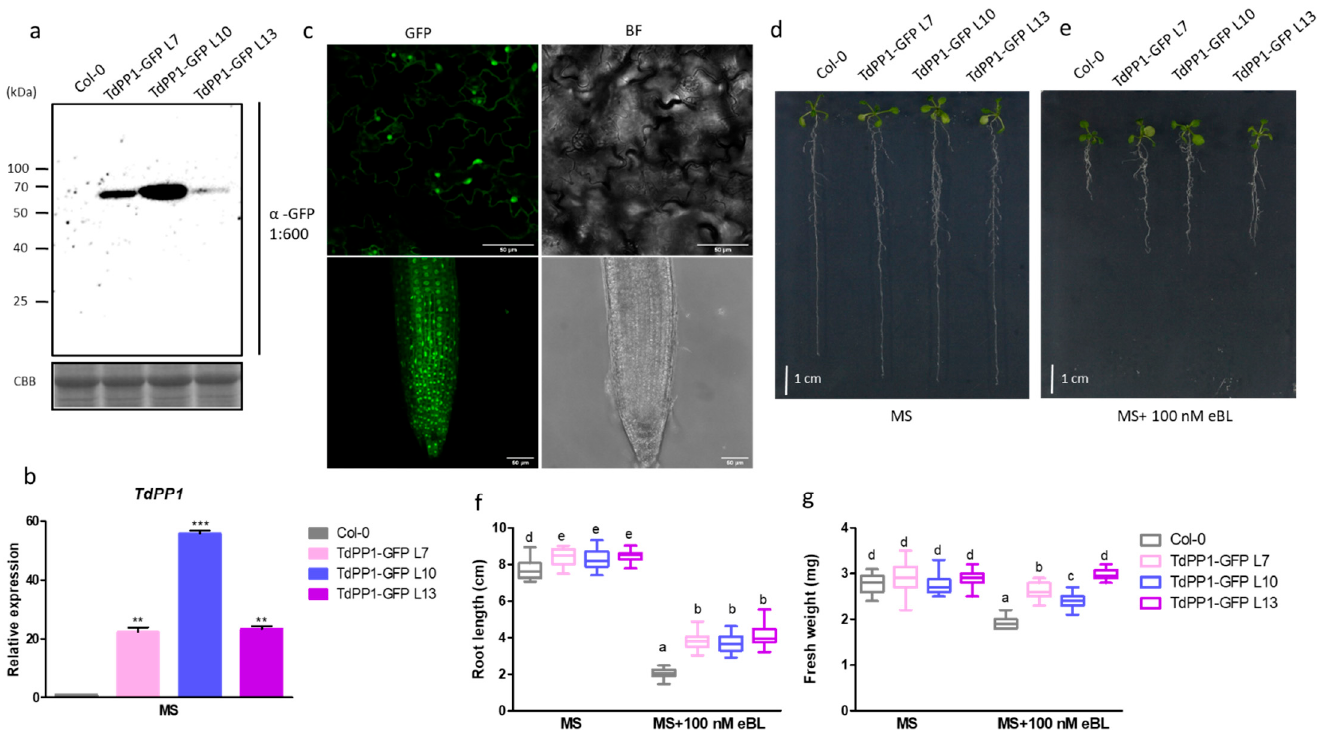
Figure 1. Arabidopsis TdPP1 overexpression promotes root growth in the presence of eBL. ( a ) TdPP1-GFP is expressed at different levels in transgenic Arabidopsis lines. Western blot using anti-GFP antibody ( α -GFP) on total proteins extracted from WT and three different transgenic TdPP1-GFP (L7, L10 and L13) lines grown for 7 days in half-strength MS medium. CBB: Coomassie Brilliant Blue. ( b ) Analysis of TdPP1 expression in Arabidopsis WT plants, and TdPP1 OE (L7, L10 and L13). These plants were grown on half MS medium for 7 days, seedlings were collected and the expression level of the TdPP1 was quantified by qRT-PCR using ACT2 and GAPC2 gene as a reference gene and normalized to the expression of ACT2. ( c ) TdPP1-GFP is ubiquitously localized in Arabidopsis epidermal cells and roots of TdPP1-L10. Representative confocal images of 5-day-old TdPP1-GFP L10. Images show GFP fluorescence in green and cells/roots in bright field (BF). ( d , e ) TdPP1-GFP transgenic (L7, L10 and L13) lines have longer roots in the presence of exogenous eBL. Representative pictures of seedlings grown for 4 days in half-strength MS and transferred to half-strength MS without ( d ) or with 100 nM eBL ( e ) for 8 days. Scale bar: 1 cm. ( f ) Root length and ( g ) fresh weight of WT Col-0 and transgenicTdPP1-GFP OE lines. Different letters indicate statistically significant differences between transgenic lines and WT determined by one-way ANOVA followed by Tukey’s multiple comparison test ( p -value < 0.05). Data represent mean values, error bars are SD and n = 30 seedlings per experiment. The experiment was repeated at least three times with similar results. **: p < 0.01, ***: p <